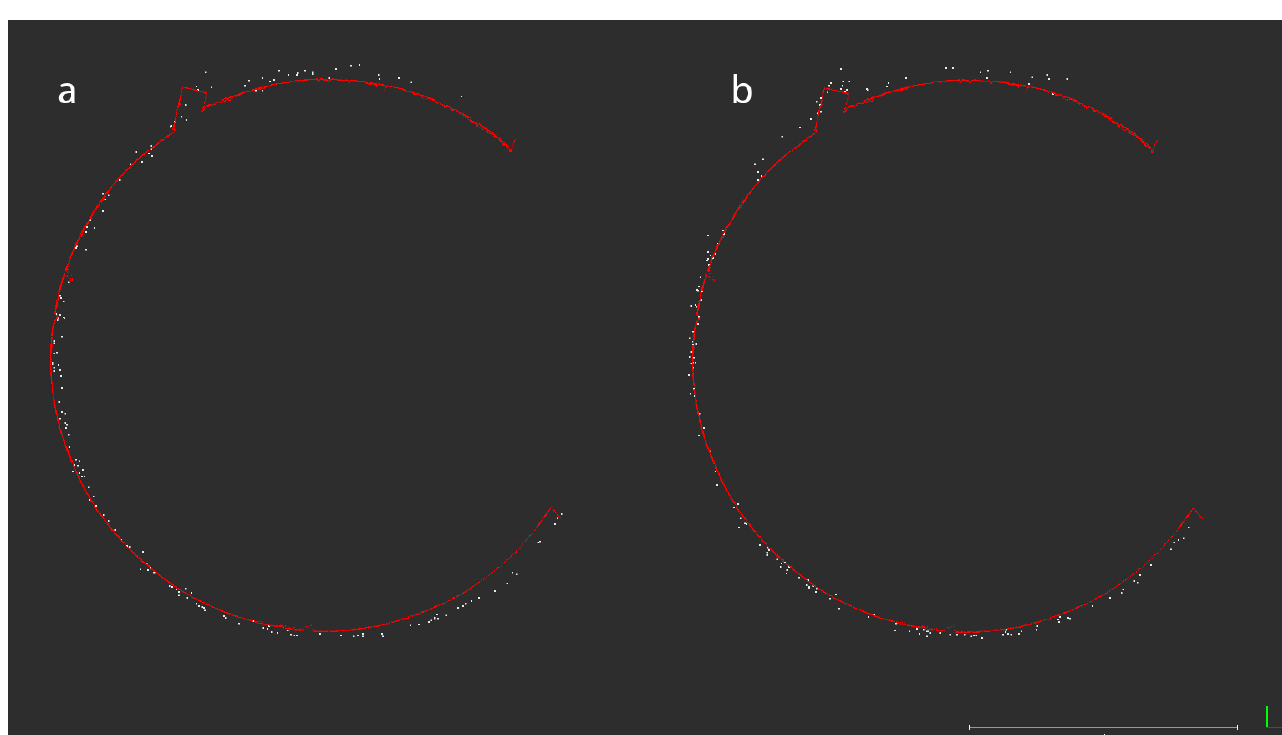
Figure 14. Section on z axis. ICP analysis on L1 data (white—aligned) and SX10 (red—static reference): ( a ) before the alignment; ( b ) after the alignment. L1 points dimension 2 pixels; SX10 points 1